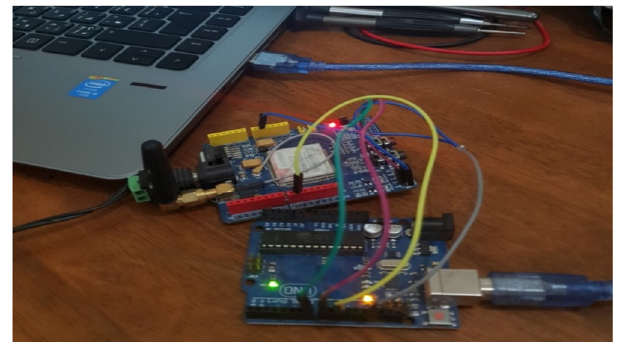
Figure 7: Mobile shield 900 with Arduino and UNO.